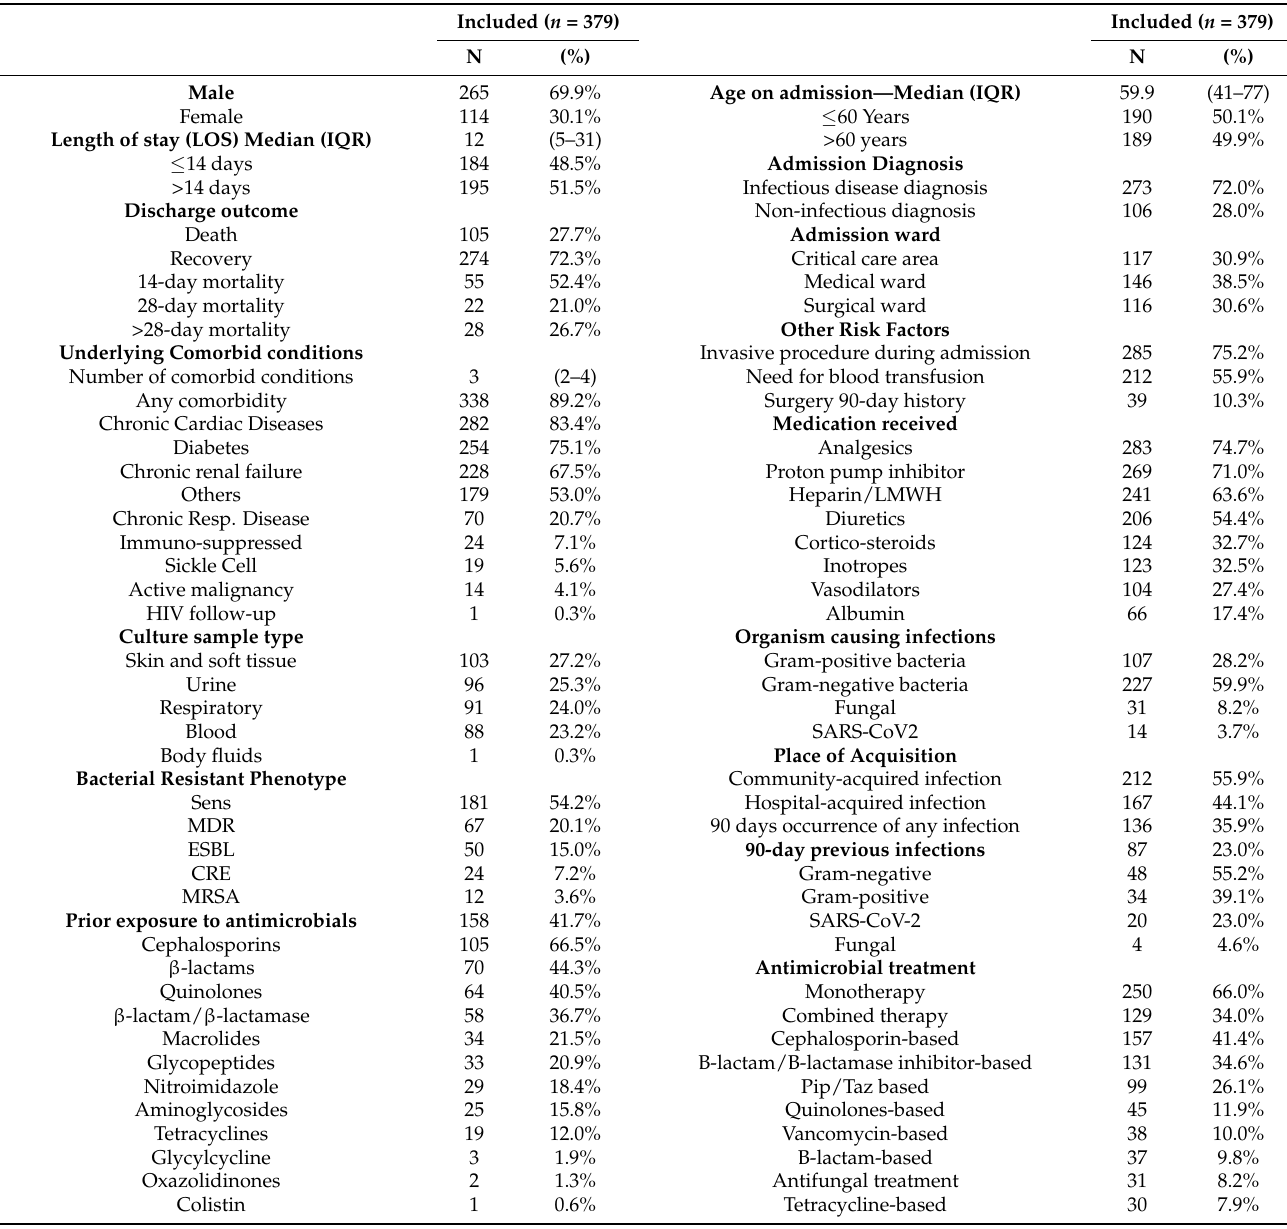
Table 1. Patient demographics and relevant clinical